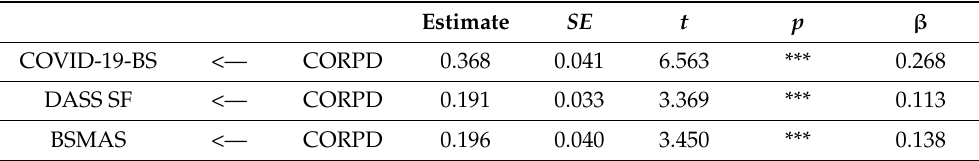
Table 7. Values of variance explained, standard error, t , p , and standardized regression